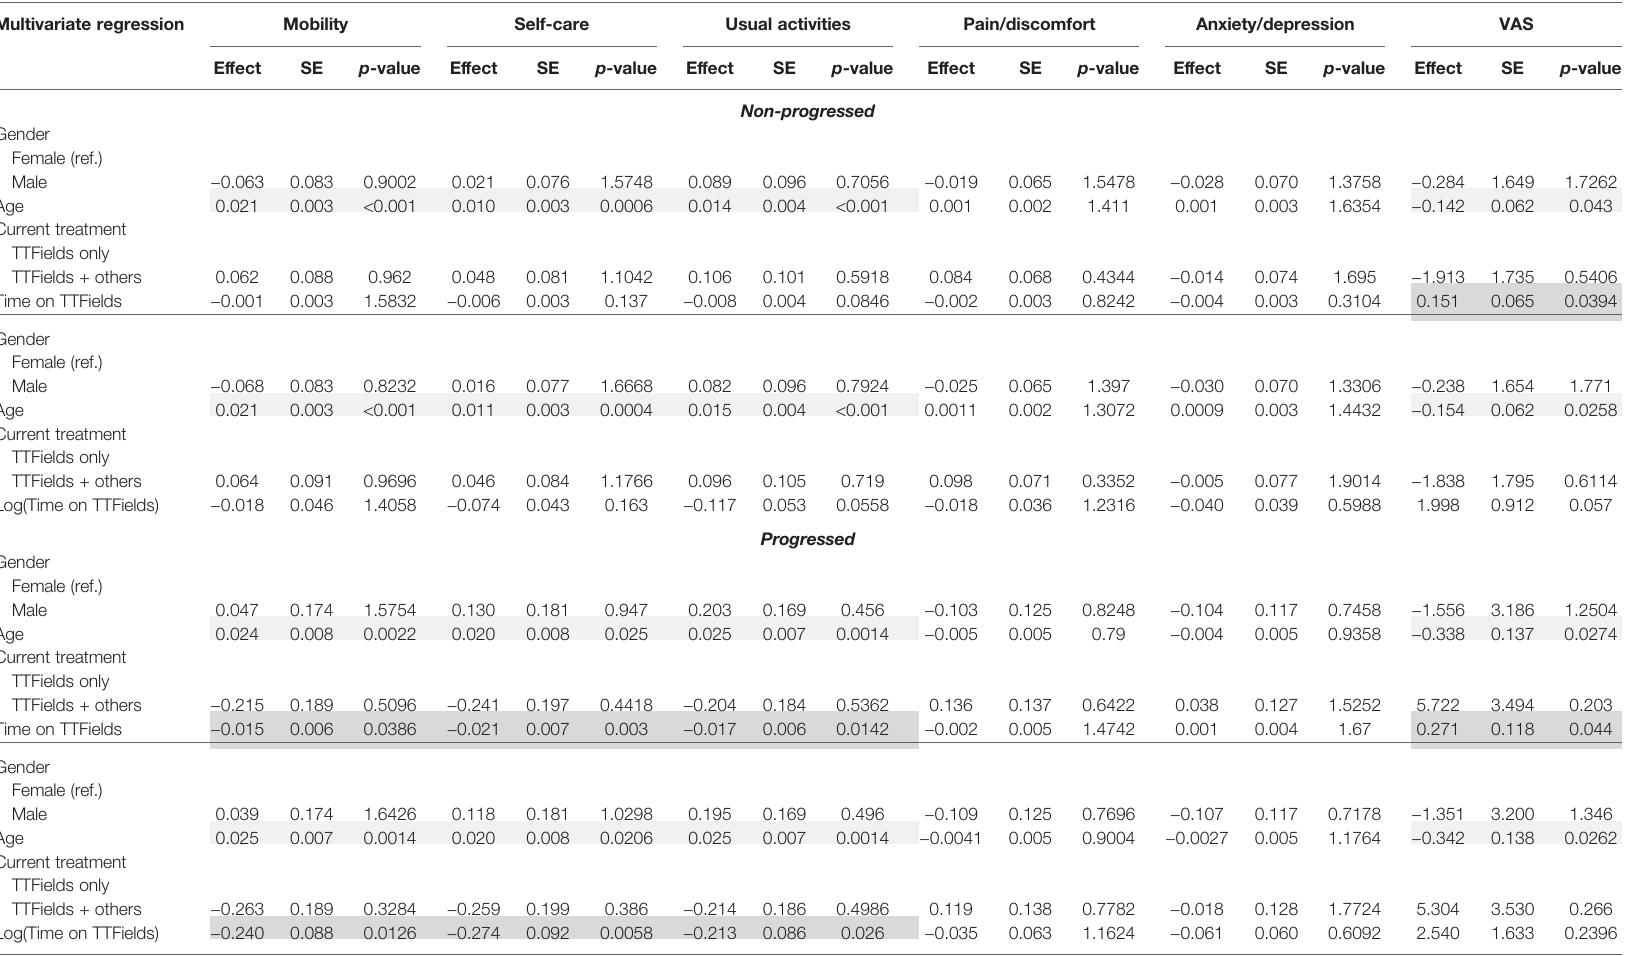
TABLE 8 | Multivariate regression results for the non-progressed and progressed subgroups with time on TTFields. Multivariate regression